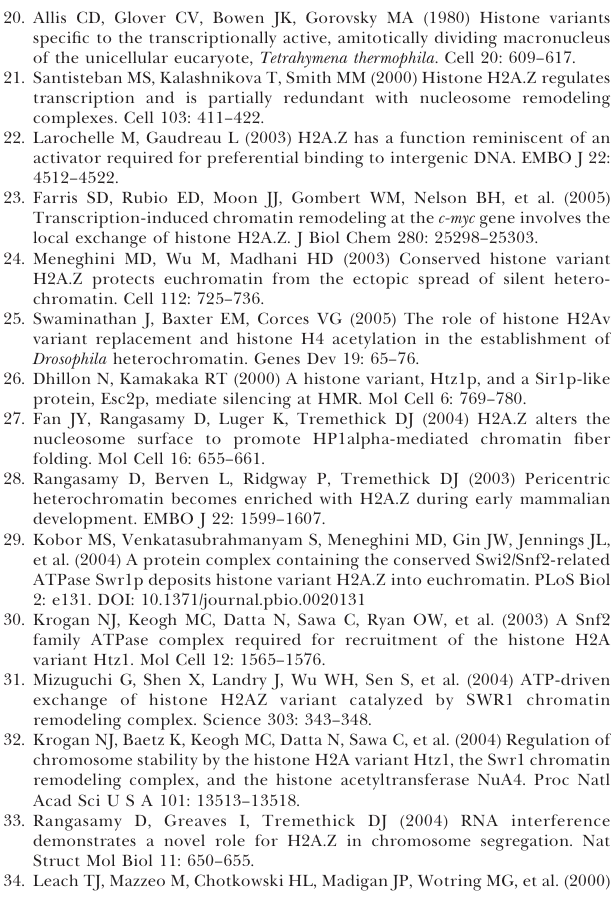
Table S7. Sequences of the Oligonucleotides Used to Quantify ChIPs by PCR in This Study Found at DOI: 10.1371/journal.pbio.0030384.st007 (28 KB XLS).